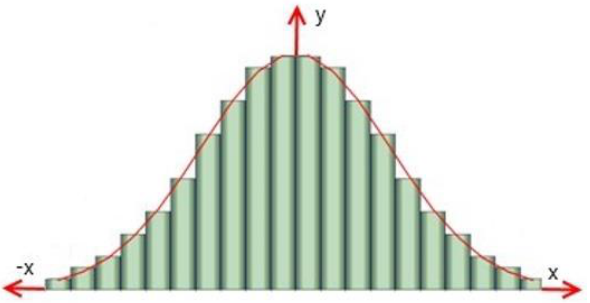
Figure 7. Differential distribution curve у = φ ( u ), where х = u = ( ω – ξ )/( ξ · σ ) based on the histogram.